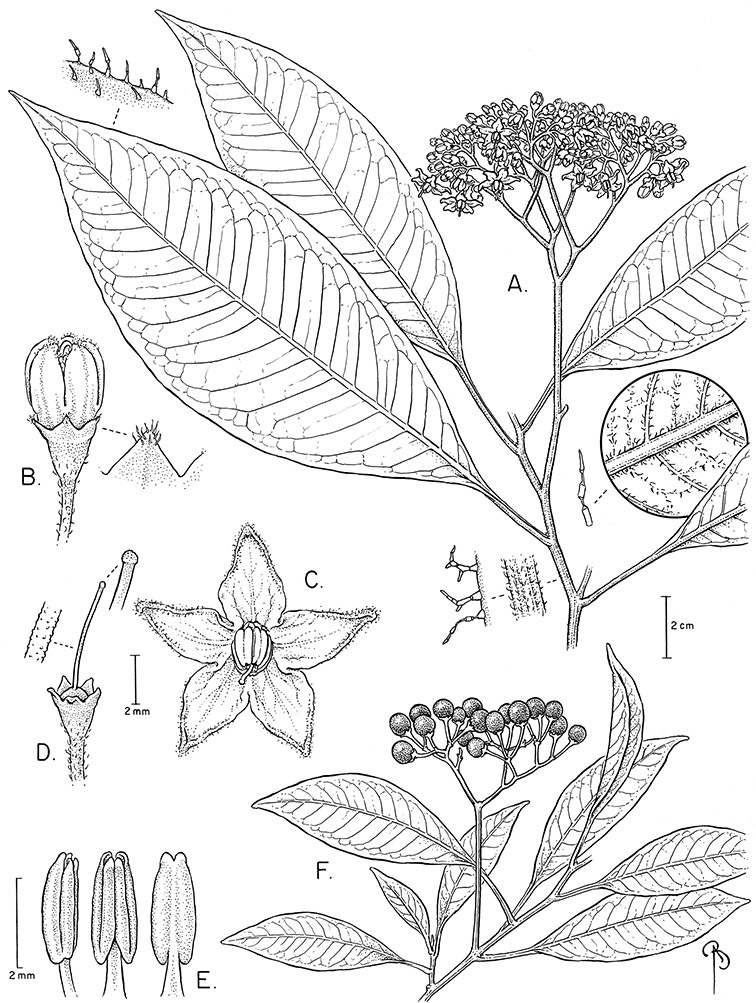
Solanum pubigerum Dunal. (A–E drawn from Reveal et al. 4230
F–G drawn from de Avila 178). Illustration by Bobbi Angell.